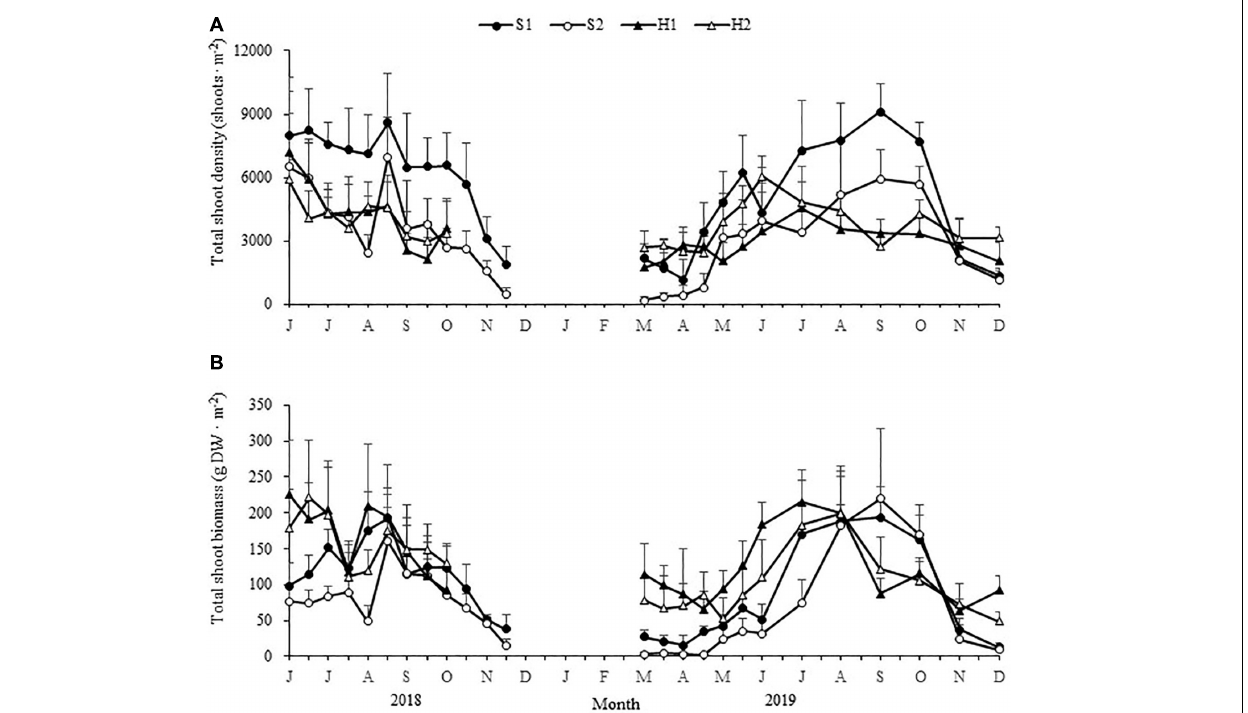
FIGURE 4 | Seasonal changes in total shoot densities (A) and biomasses (B) of Zostera japonica at the four study sites from June 2018 to December 2019. Values are mean ± SD ( N = 7 cores per site). TABLE 1 | The total shoot density and biomass of Zostera japonica among the four study sites at the beginning of spring (2019.3.15). Variable S1